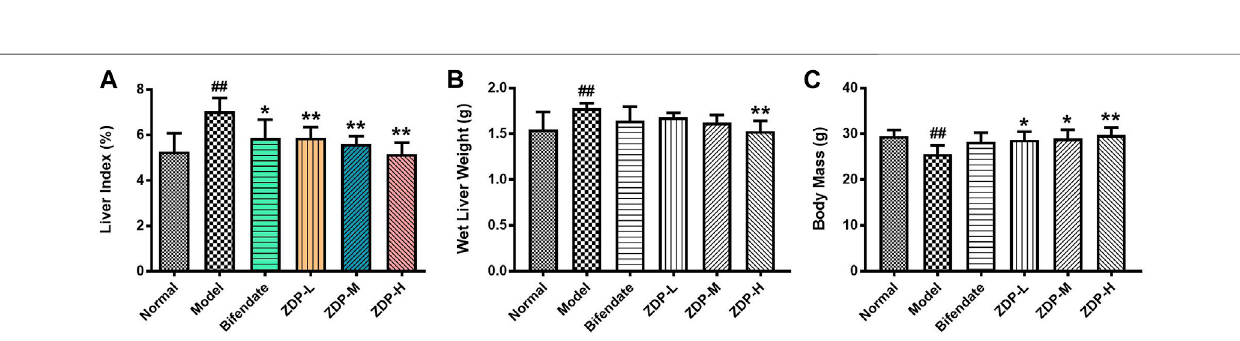
FIGURE3| ZDPdecreasestheliverindex,wetliverweightandbodymassinthemurinemodelofALIinducedbyCCl 4 .Liverindex (A) ,wetliverweight (B) andbody mass (C) were measured in mice (Normal control, Model control, Bifendate-treated control, ZDP-L, ZDP-M and ZDP-H). Data from six to eight mice per group are expressed asthemean ± SD. Statisticalanalysis: ## p < 0.01compared withthenormalgroup;* p < 0.05, ** p < 0.01compared withthemodelgroup, One-Way ANOVA.